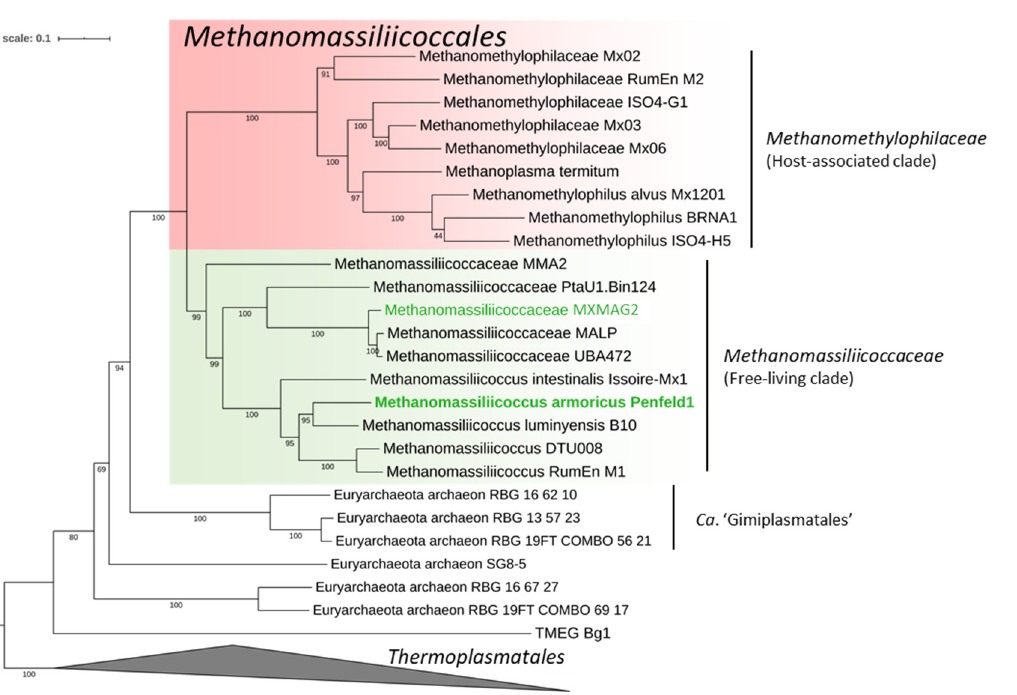
Figure 4. Maximum Likelihood phylogenomic tree (LG + F + G4) showing the position of the two Methanomassiliicoccales MAGs obtained in this study (in green) with respect to closely related MAGs and taxa. This phylogeny is based on a concatenation of 40 conserved phylogenetic markers (10,111 positions). The scale bar represents the average number of substitutions per site, and numbers indicate bootstrap replicates.